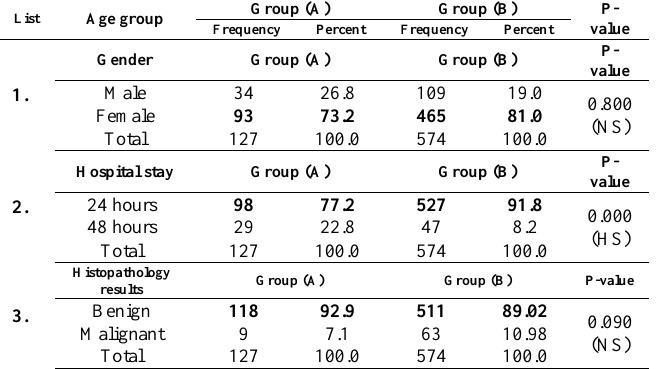
Table 1 : Distribution of patients’ socio-demographic and clinical characteristics of the study sample